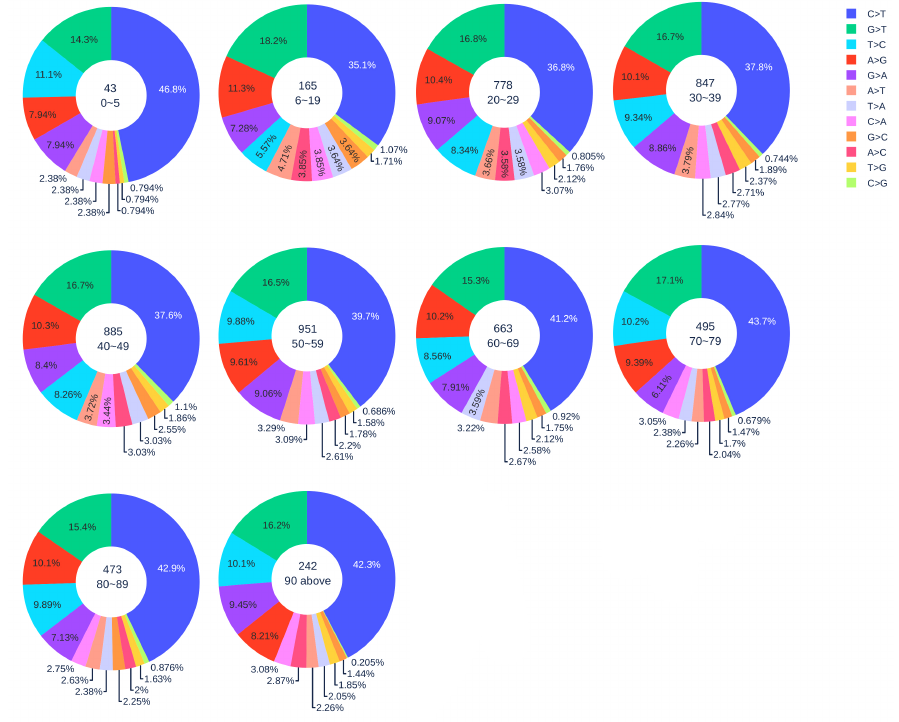
Figure 3. The distribution of 12 SNP types among unique mutations in the SARS-CoV-2 genome isolates from different age groups among female patients. The text inside each circle represents the total number of records that have age information for different age groups.